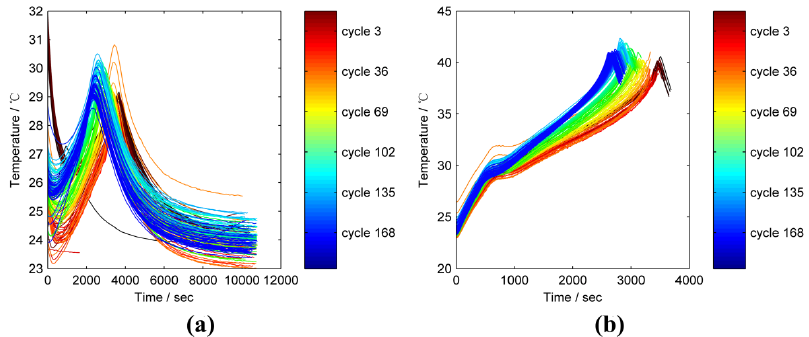
Figure 3. Varying charge and discharge temperature curves of battery 7 of 168 cycles. ( a ) The varying charge temperature curves; ( b ) The varying discharge temperature curves.